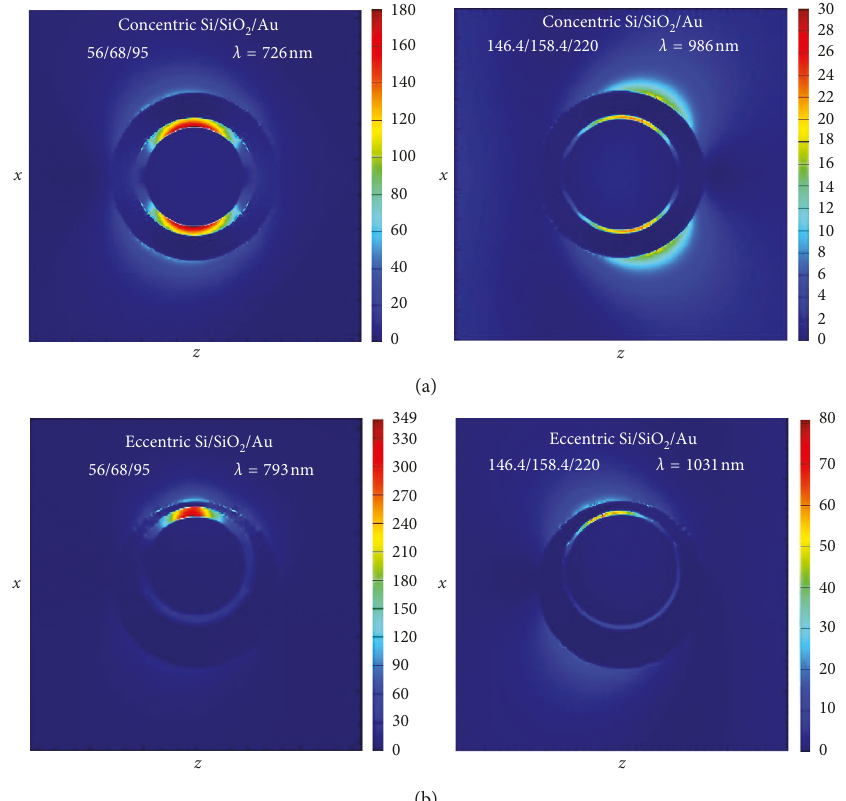
Figure 7: The spatial distribution in the xoz plane of the relative intensity of the electric field (| E | 2 / | E corresponding to relevant absorption and scattering resonances supported by a concentric (a) and eccentric (b) Si/SiO 2 /Au multishell in biological